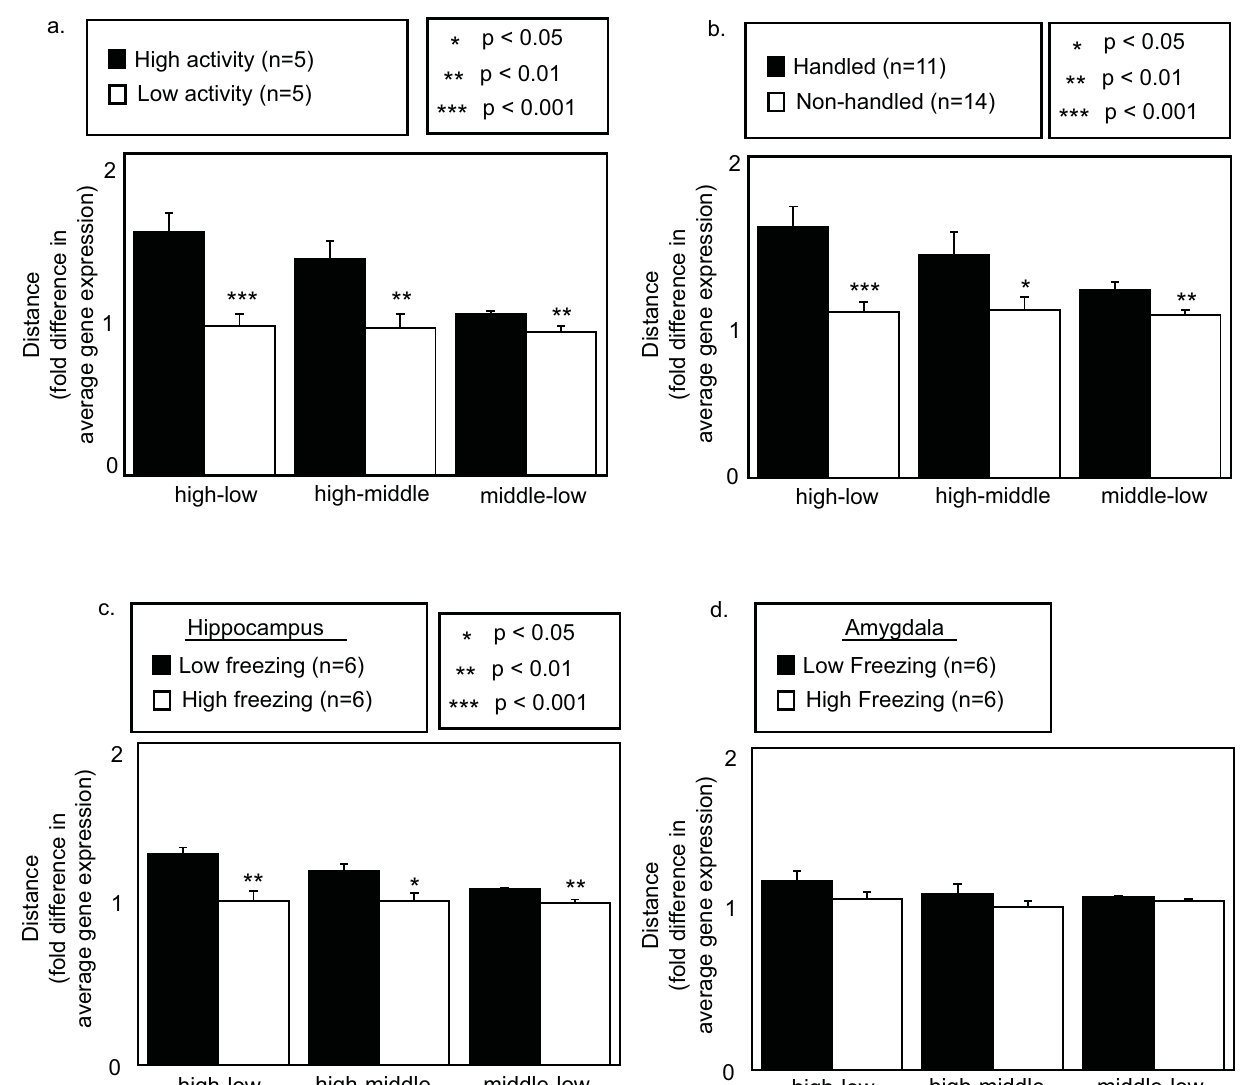
Figure 5. Increased variance in gene expression in more active mice relates to a moving apart of log-normal distributions. We find, in all cases where variance is increased, that a corresponding increase in the distance between log-normal distributions is present. The distance is measured between peaks in natural logs. We present the data normalized to the less active group of animals and converted into linear fold change of expression levels. For example, if the distance between the high and low expression groups of genes was 1 natural log greater in more active animals, then the difference would be the natural exponent taken to the power of 1 or 2.718. This would mean that when compared to the low expression group of genes that the high expression group of genes is up-regulated on average 2.718-fold. Significant differences in separation were found between the low and middle, middle and high, and high and low distributions in all cases. Importantly, significant differences in separation of distributions were found in the hippocampus but not in the amygdala between high and low freezing mice. This is consistent with the findings for the variance (figure 3).